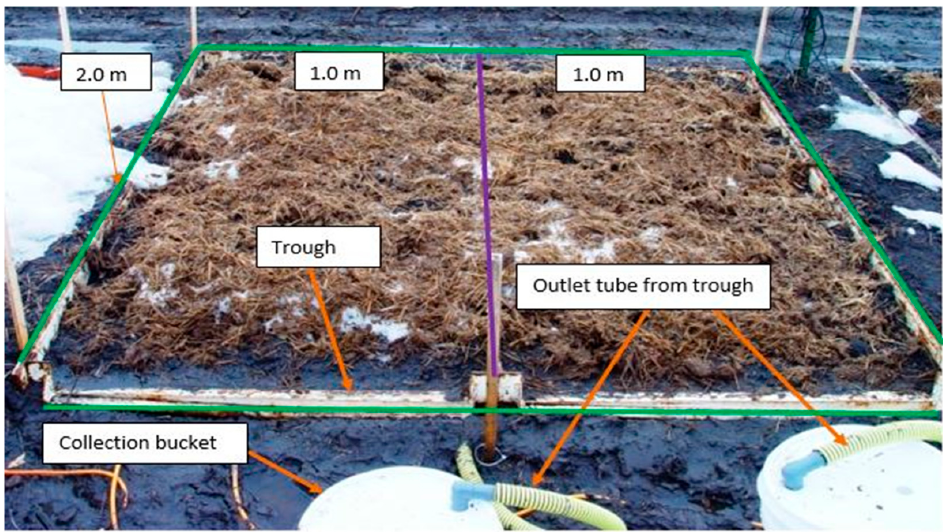
Figure 1. Plot configuration for snowmelt study.